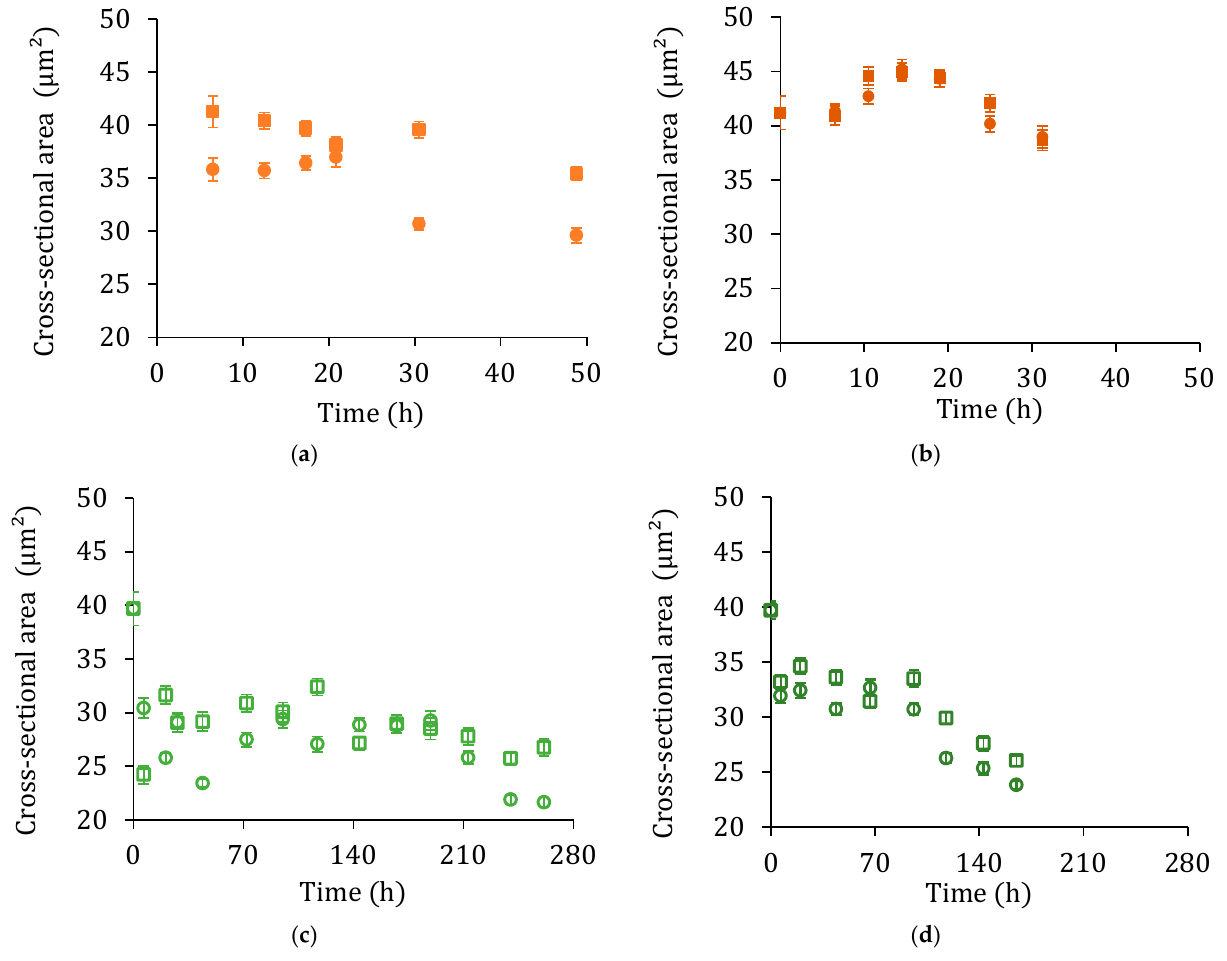
Figure 7. Average overall yeast cell CSA plotted over time: ( a ) LTHF (orange); ( b ) HTHF (dark orange); ( c ) LTLF (green); ( d ) HTLF (dark green). Fermentations were performed in duplicate. The data shown represent yeast cell CSA under vacuum (circles) and atmospheric pressure (squares); high FAN (filled) and low FAN (empty); high temperature (darker shade) and low temperature (lighter shade); viability (crosses).